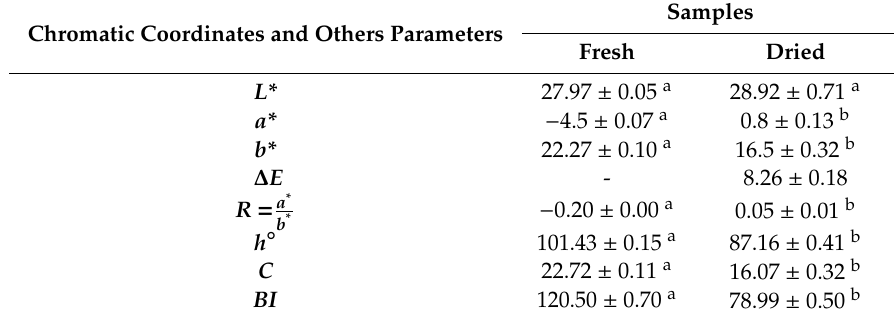
Table 3. Chromatic Coordinates of Lettuce in Fresh ( n = 10) and after Drying process ( n = 20). Color Di ff erence ( ∆ E ), Ratio of redness over yellowness ( R ), and Browning Index ( BI ) ( n = 3), fresh and after the drying process.